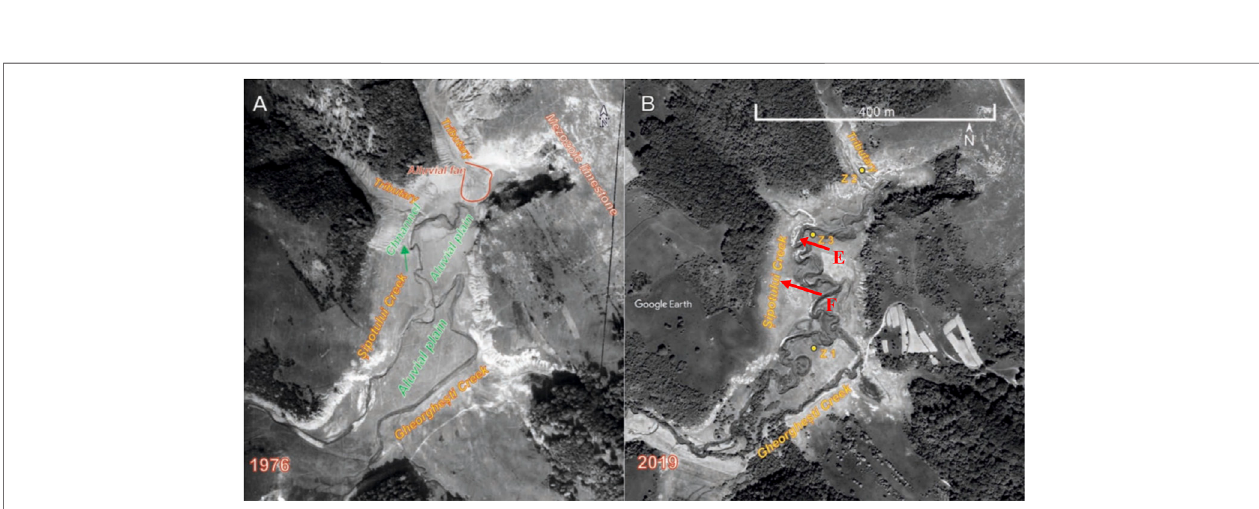
FIGURE8| AerialimagesoftheZ ă tonBasintakenin1976 (A) ;source:TheEmilRacovitaInstituteofSpeleologyarchive);andin2019 (B) ;source:GoogleEarth).It shows a variable morphology through time from a relatively straight fl uvial style in 1976 to a meandering style in 2019. The difference in the forest cover around the lake from 1976 to 2019 should be noted, with a slight increase more recently.